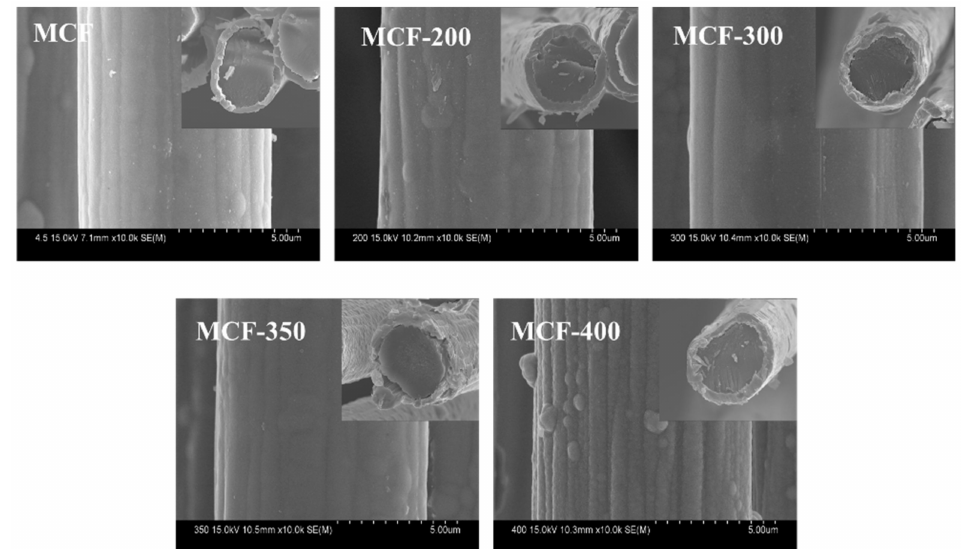
Figure 1. SEM images of MCF as a function of heat treatment temperature.